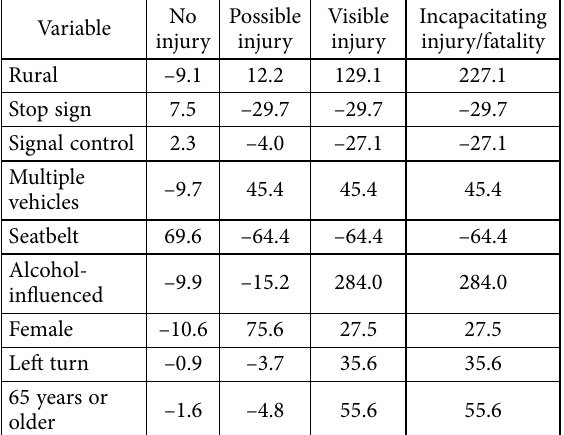
Table 3. Average variable pseudo